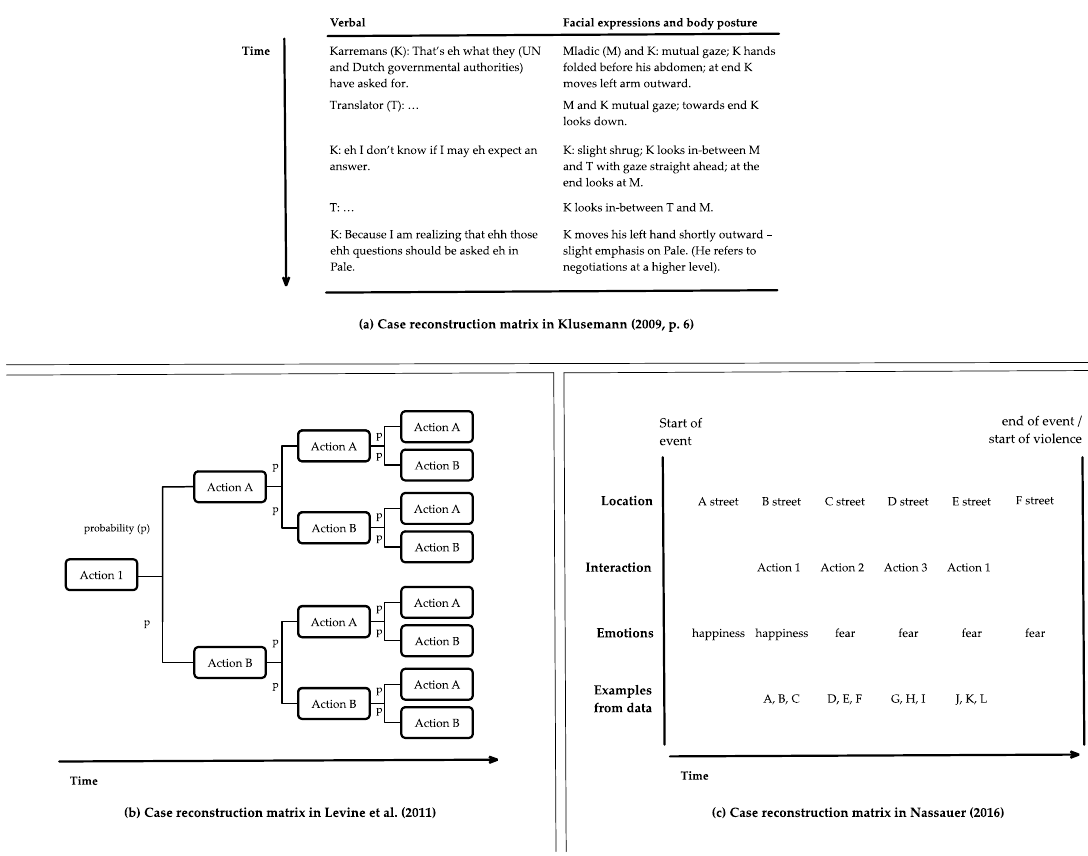
Figure 3. Case reconstruction matrices.